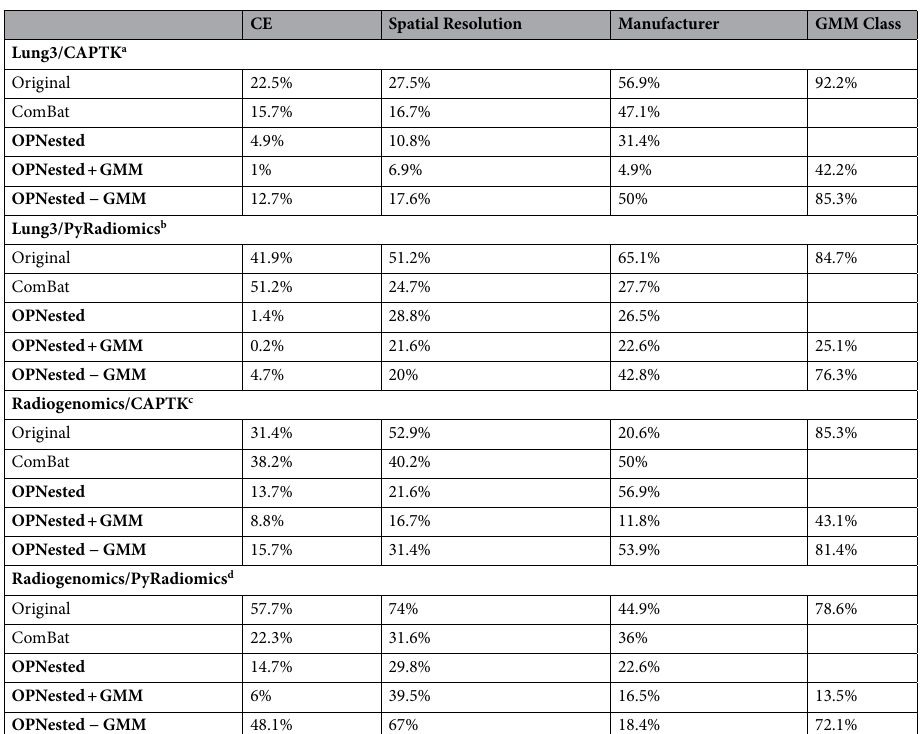
Table 2. Percentage of features out of the original number of features with significantly ( p < 0.05) different distributions attributable to batch effects in the original features and after applying standard ComBat, OPNested ComBat, OPNested + GMM ComBat, and OPNested – ComBat. Order indicates order of batch effects used in sequential harmonization for multiple batch effects. GMM groupings are generated by selecting the best model out of a set of GMMs estimated from each feature, thus GMM feature indicates the feature corresponding to the best model used to generate the final GMM grouping for all features. a Nested Order: Manufacturer, Spatial Resolution, CE, Nested + GMM Order: Spatial Resolution, GMM, Manufacturer, CE, Nested – GMM Order: CE, Manufacturer, Spatial Resolution, GMM Feature: T1_E_GLRLM_ ShortRunLowGreyLevelEmphasis. b Nested Order: CE, Spatial Resolution, Manufacturer, Nested + GMM Order: Spatial Resolution, CE, GMM, Manufacturer, Nested-GMM Order: Manufacturer, CE, Spatial Resolution, GMM Feature: ldmn. c Nested Order: Manufacturer, CE, Spatial Resolution, Nested + GMM Order: GMM, CE, Spatial Resolution, Manufacturer, Nested-GMM Order: Manufacturer, CE, Spatial Resolution, GMM Feature: T1_ED_GLRLM_Bins-10_Radius-1_ShortRunLowGreyLevelEmphasis. d Nested Order: Spatial Resolution, Manufacturer, CE, Nested + GMM Order: Spatial Resolution, GMM, Manufacturer, CE, Nested – GMM Order: CE, Spatial Resolution, Manufacturer, GMM Feature: